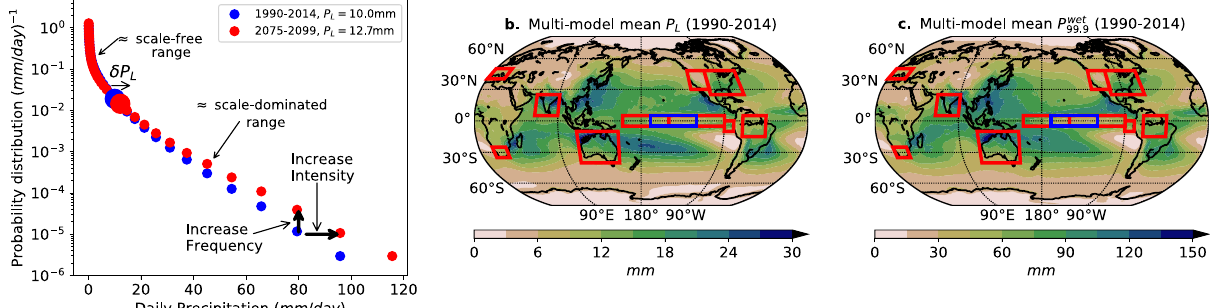
Figure 1. ( a ) Example of simulated daily precipitation probability distributions in the historical and global warming (SSP5 8.5) runs in the CNRM-CM6-1 model for the Western United States (30 ◦ N–48 ◦ N, 103 ◦ W–124 ◦ W). The plot showcases the two leading order probability distribution regimes: an approximately scale-free range controlling the probability of low and moderate daily precipitation values, and a scale-dominated range controlling the large-event tail. The scale P L is a key parameter controlling the intensity and frequency of extreme daily precipitation events. ( b ) Multi-model mean of P L in the CMIP6 historical run (1990–2014). ( c ) Multi-model mean of the 99.9th wet-day daily precipitation percentile in the CMIP6 historical run (1990–2014). Red boxes show the location of regions used to exemplify behavior in this and remaining figures. The Niño 3.4 region is shown in blue as it overlaps Niño 3 and Niño 4 regions. Maps were generated using Python’s 30 Matplotlib 31 Basemap 32